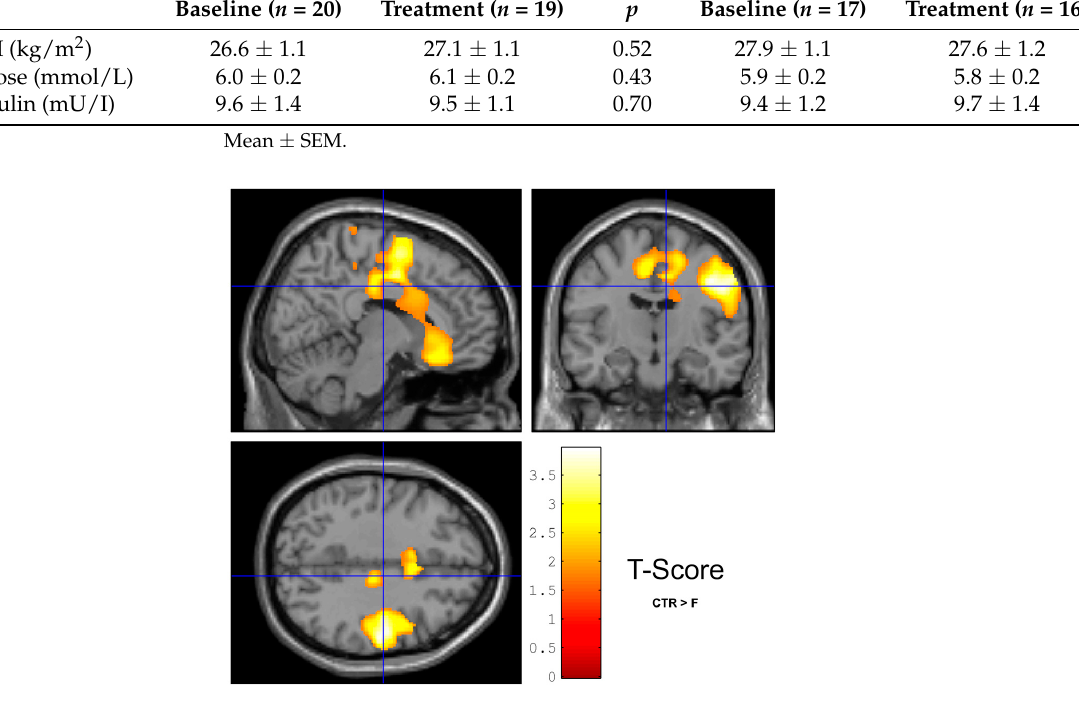
Figure 1. WM density was greater in controls (CTR) than in frails (F) with statistical minima in zones close to the right pre- and post-central regions. The yellow color marks for t -value of the statistical test between the groups, with darkest visualized color at p = 0.05.